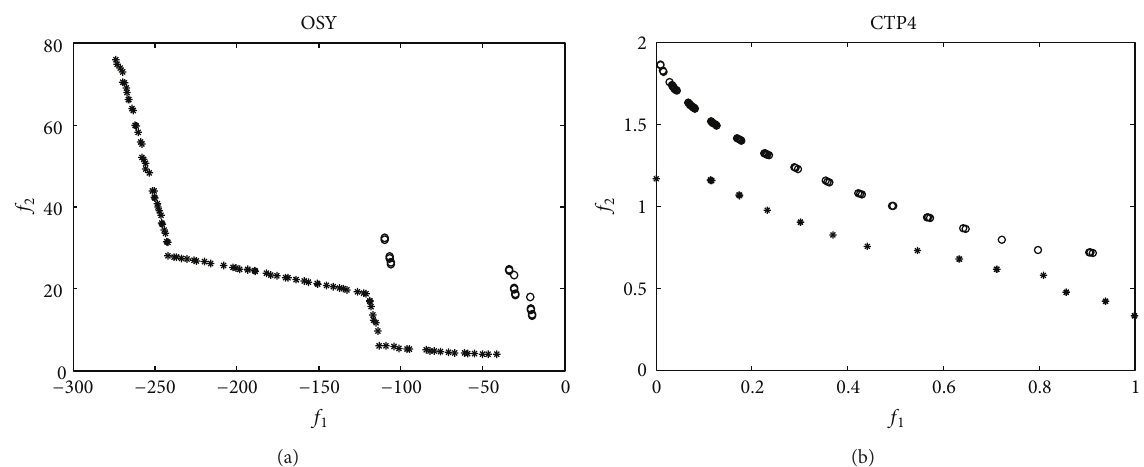
Figure 2: Final Pareto front for OSY and CTP4 under original and novel migration operator.